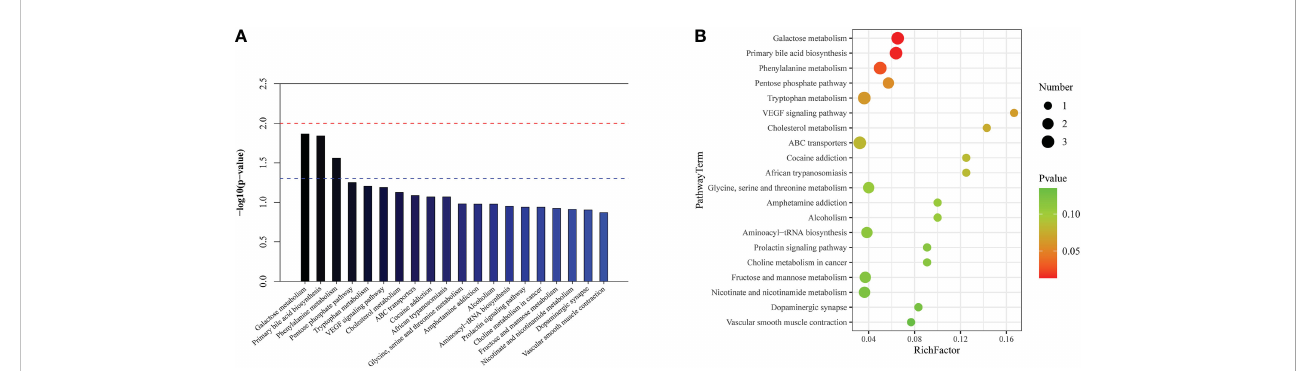
FIGURE 7 The signi fi cantly enriched pathways involved in cardiac dysfunction group. (A) Top-20 metabolic pathway enrichment map. (B) Top-20 bubble